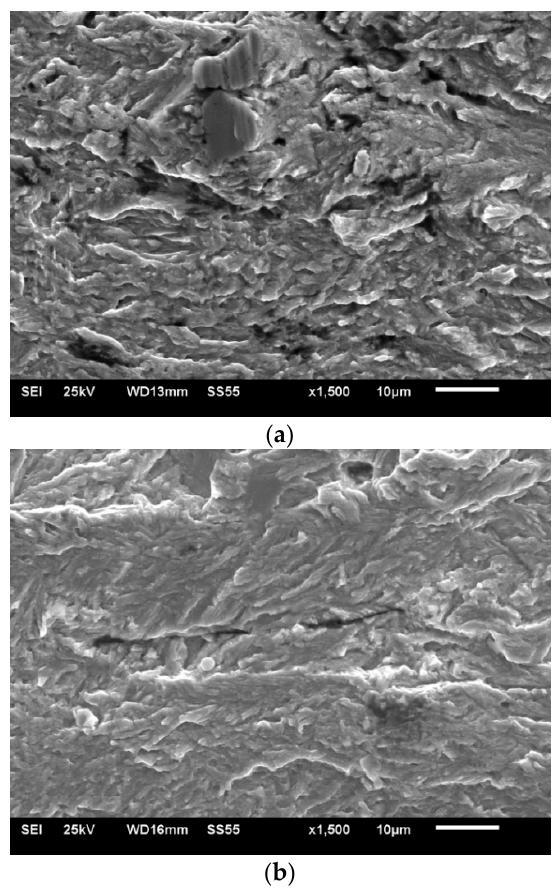
Figure 12. Typical Fatigue Fracture Surface Features Present in the Annealed 4140 Samples. ( ∆ K = 12 MPa √ m; crack growth direction was from top to bottom of photos). ( a ) Uncharged (No Hydrogen); ( b ) Hydrogen-Charged.